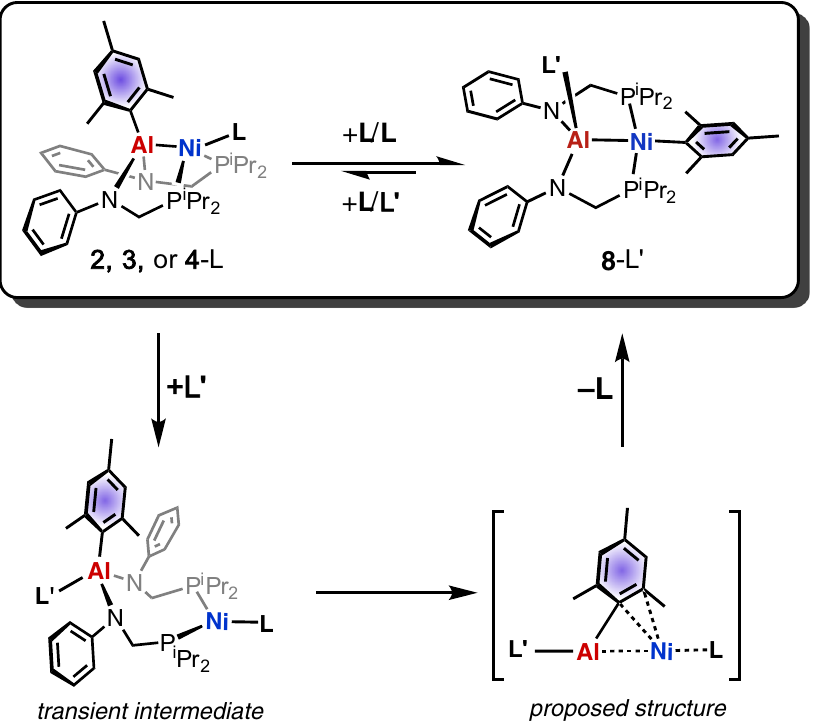
Fig. 1 Aryl group transfer in a nickel – aluminium pincer complex. Top: Coordination of O-donor ligands, such as THF (denoted L), induces Al – Ni bond cleavage and aryl group (shaded blue) migration. The process is reminiscent of key transmetalation steps involved in cross-coupling reactions 1 . Copyright Wiley-VCH GmbH. Reproduced with